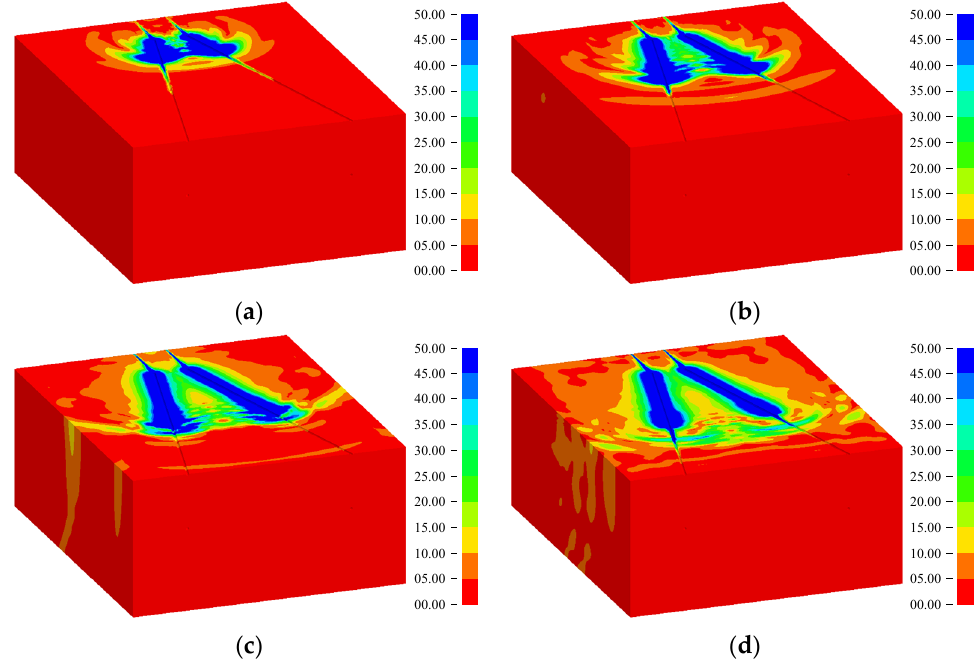
Figure 5. Stress wave propagation under the condition of Φ 32 mm holes matching Φ 27 mm cartridges. ( a ) Time = 160 µs. ( b )Time = 320 µs. ( c ) Time = 470 µs. ( d ) Time = 600 µs.